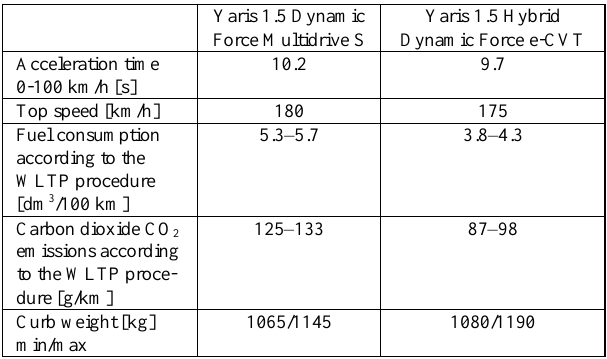
Table 1. Specifications of Yaris 1.5 Vehicle Dynamic Force Multidrive S and Yaris 1.5 Hybrid Dynamic Force